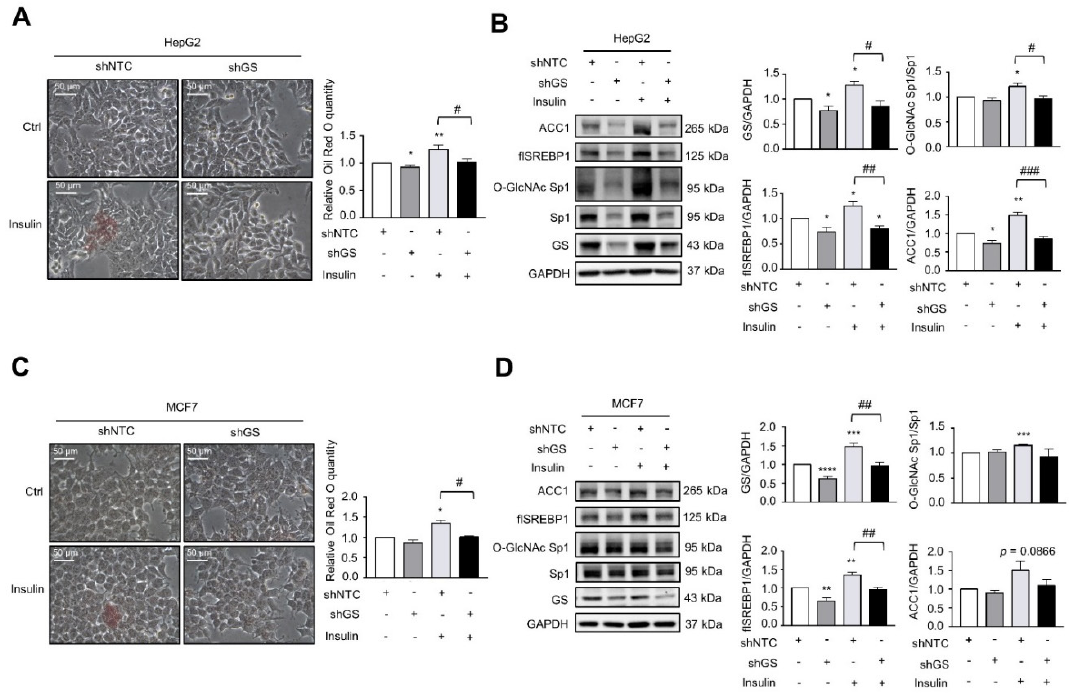
Figure 3. Knockdown of GS attenuates insulin-induced LD formation and O-GlcNAc-Sp1/SREBP1/ACC1 expression. ( A , B ) HepG2 cells stably transfected with non-targeting control or GS shRNA were cultured in the absence or presence of 200 nM insulin for 48 h. ( C , D ) MCF7 cells stably transfected with non-targeting control or GS shRNA were cultured in the absence or presence of 200 nM insulin for 48 h. ( A , C ) LD was stained with Oil Red O and normalized to protein concentrations for the quantitative analysis. ( B , D ) Cell lysates were analyzed by Western blot with specified antibodies. flSREBP1: full-length SREBP1. The bar graphs on the right represent the densitometry analyses of the ratios of indicated proteins. Data represent means plus SEM. * p < 0.05, ** p < 0.01, *** p < 0.001, and **** p < 0.0001 compared to control cells. # p < 0.05, ## p < 0.01, and ### p < 0.001 between indicated groups.